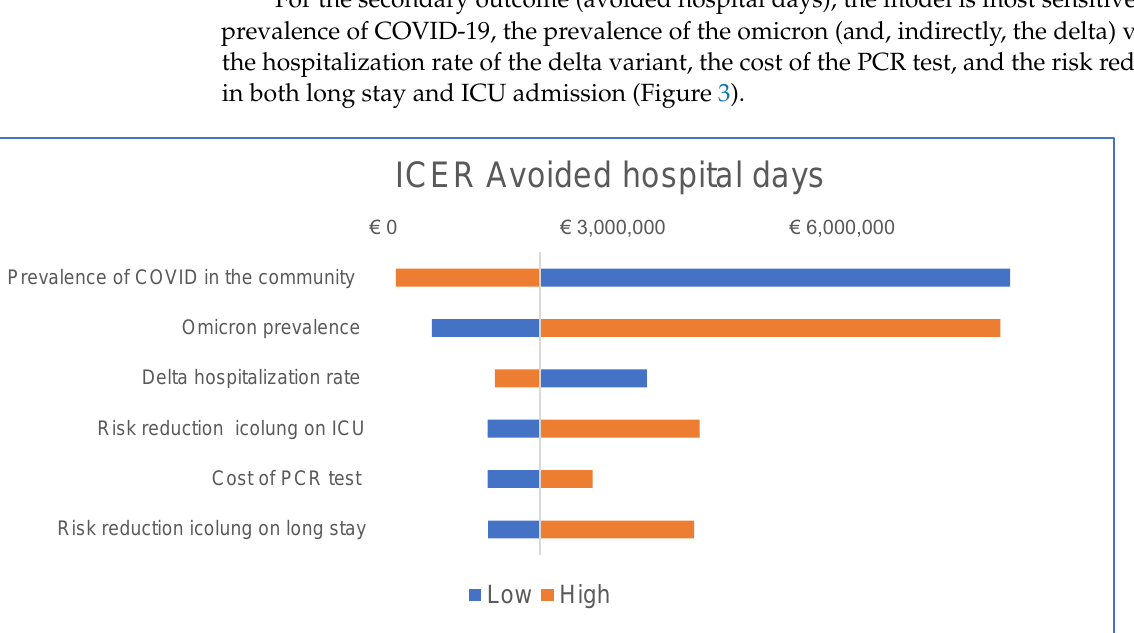
Figure 3. Tornado diagram: secondary outcome, RP vs. RP with icolung.